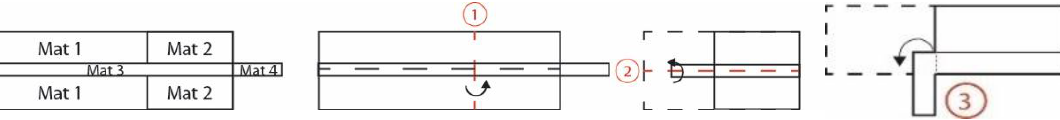
Figure 11. Crossfolding of final structure of method 1. Figure 12. Sequence of crossfolding for method 2. Opposite from method 1, method 2 was created by folding along fold line 2 across the structure, followed by folding along fold line 1. The bottom hinge was subsequently folded inwards. Figure 13 shows the crossfolded structure using method 2. Figure 13. Crossfolding of final structure of method 2. The results for design and crossfolding of multimaterial smart structures are described in Section 3. 3. Results and Discussion 3.1. Shape Recovery of Single Material Specimens The recovery rates (in percentage) of four different materials are shown in Figure 14. DM8530 achieved the highest recovery rate whilst VeroWhitePlus had the lowest recovery rate. Due to the better recovery property, DM8530 should have a better ability to take the multi-folding process.